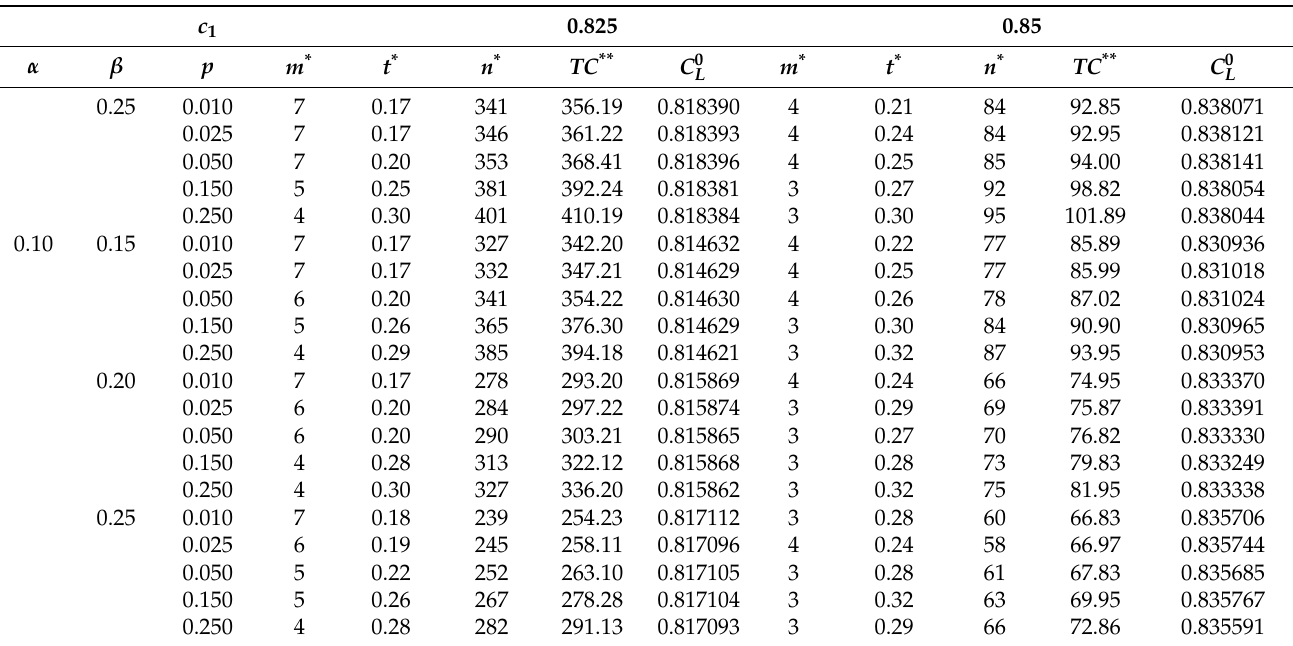
Table A4. The optimal ( m *, t *), n *, total cost TC ** and the critical value for c 1 = 0.875, 0.90 and p =